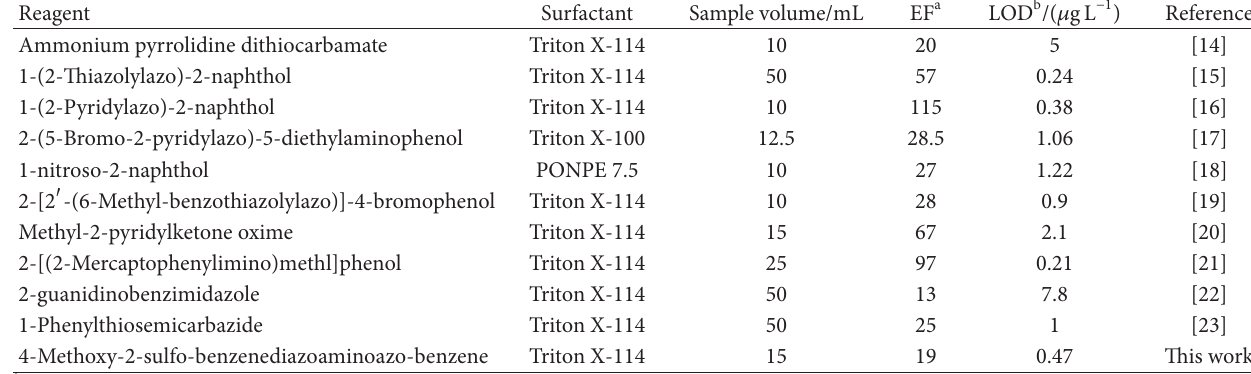
T 4: Procedure using cloud point extraction prior to cobalt determination by FAAS.